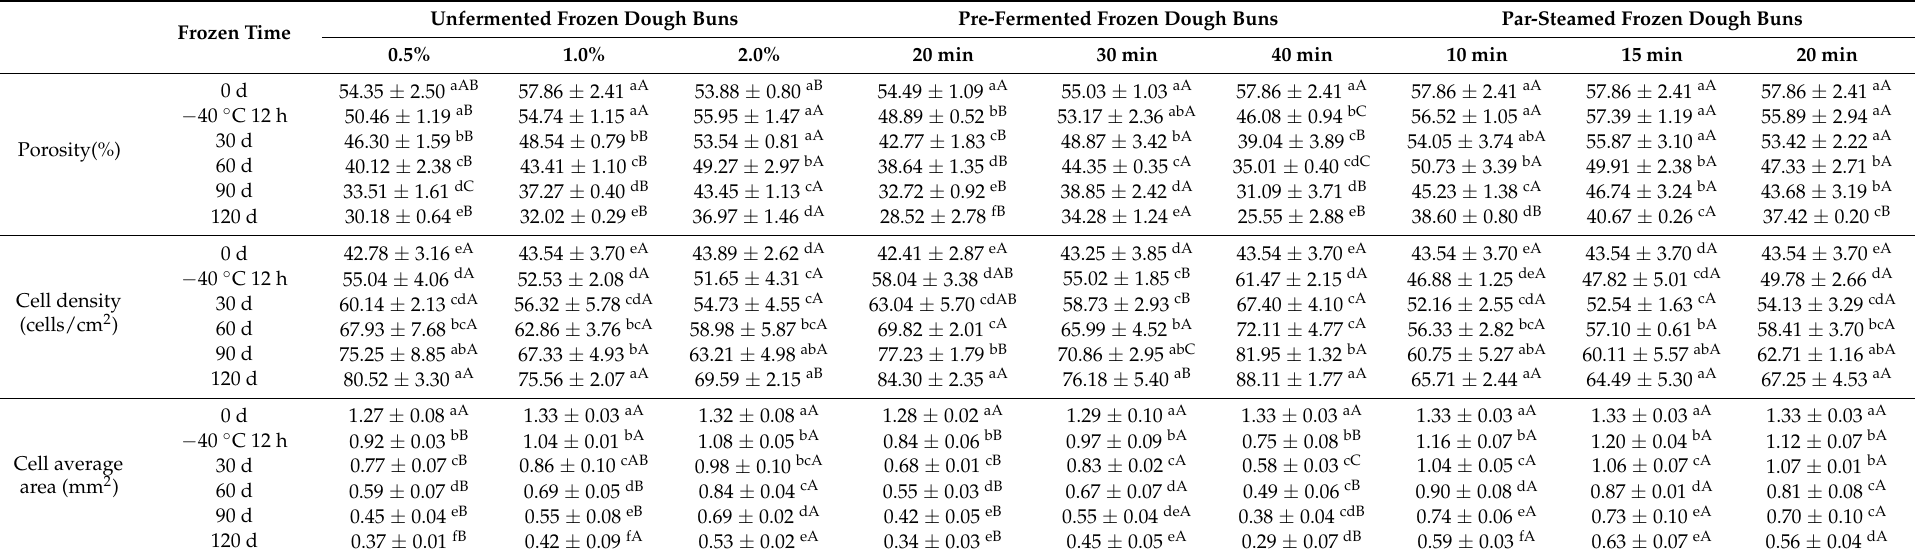
Table 2. Effects of different processes on the internal pore structure parameters of frozen dough